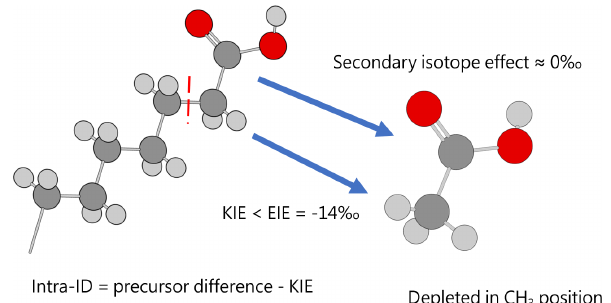
Figure 4. Acetic acid produced from pyrolysis of precursor acid forms has an Intra-ID that is depleted in 13 C in the methyl position. Dark gray, light gray, and red spheres represent carbon, hydrogen, and oxygen atoms,